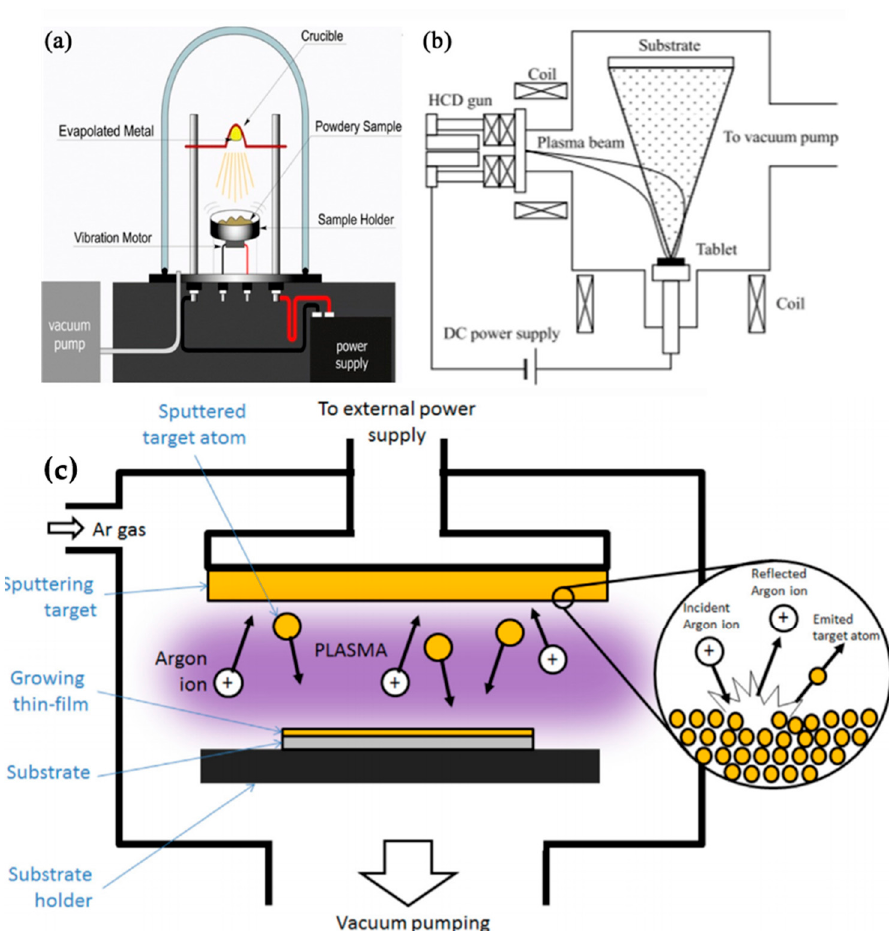
Figure 18. The three most common PVD coating approaches, where ( a ) shows a vacuum deposition process [158], ( b ) illustrates a schematic drawing of the ion-plating method [159], and ( c ) demonstrates the physical sputtering processes [160]. Reproduced with permission from [160]. Elsevier, 2015. Table 8. The three-key state-of-the-art PVD coating technologies for GTE compressor blades [161–170]. Coating Method